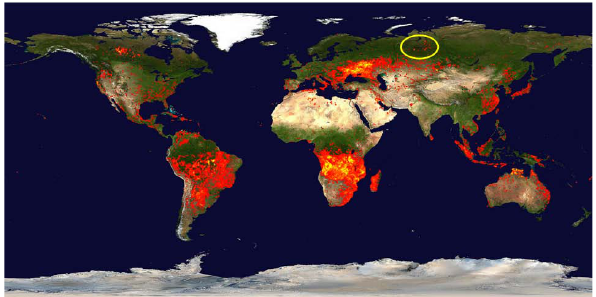
Fig. 14. Global fire map of all fires detected during a ten-day period (8–17 August 2008) by the Moderate Resolution Imag- ing Spectroradiometer (MODIS). Low fire counts are represented by red dots and high fire counts by yellow dots. Yellow oval shows the likely origin of the pollution plume observed dur- ing the ASCOS 2008 expedition helicopter flight on 20 August 2008. Source: http://lance-modis.eosdis.nasa.gov/cgi-bin/imagery/ firemaps.cgi (adapted by the author).